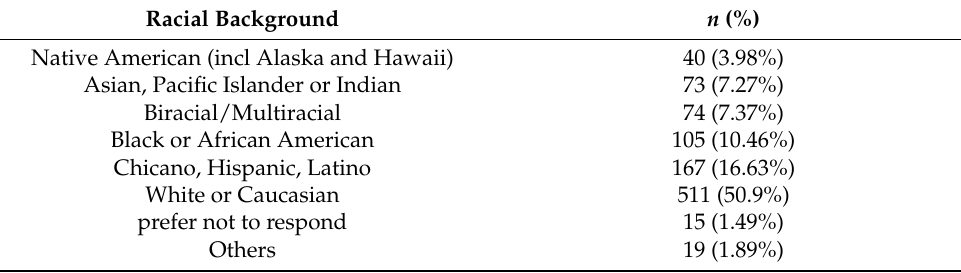
Table 4. Frequency of Racial Background. Racial Background n (%) Native American (incl Alaska and